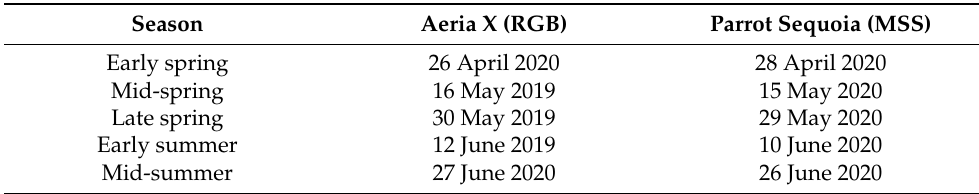
Table 2. Collection dates for each sensor with seasonal descriptions. The description is based on regional trends in phenology and not on any particular date